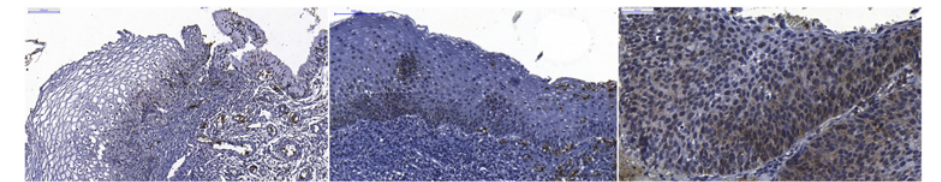
Fig 2. Immunohistochemical staining of RAP1. Left — Squamocolumnar junction of non-dysplastic cervical mucosa (NDM) showing very weak immunostaining for RAP1 in the cytoplasm of basal cells and no staining in the intermediate and superficial cells. Middle — CIN 1 showing moderate staining for RAP1 in cells distributed in the basal third of the epithelium and showing RAP1 expression in neutrophils. Right- CIN 2/3 showing strong staining for RAP1 in cells diffusely distributed throughout the entire epithelial thickness, with nuclear translocation of RAP1.